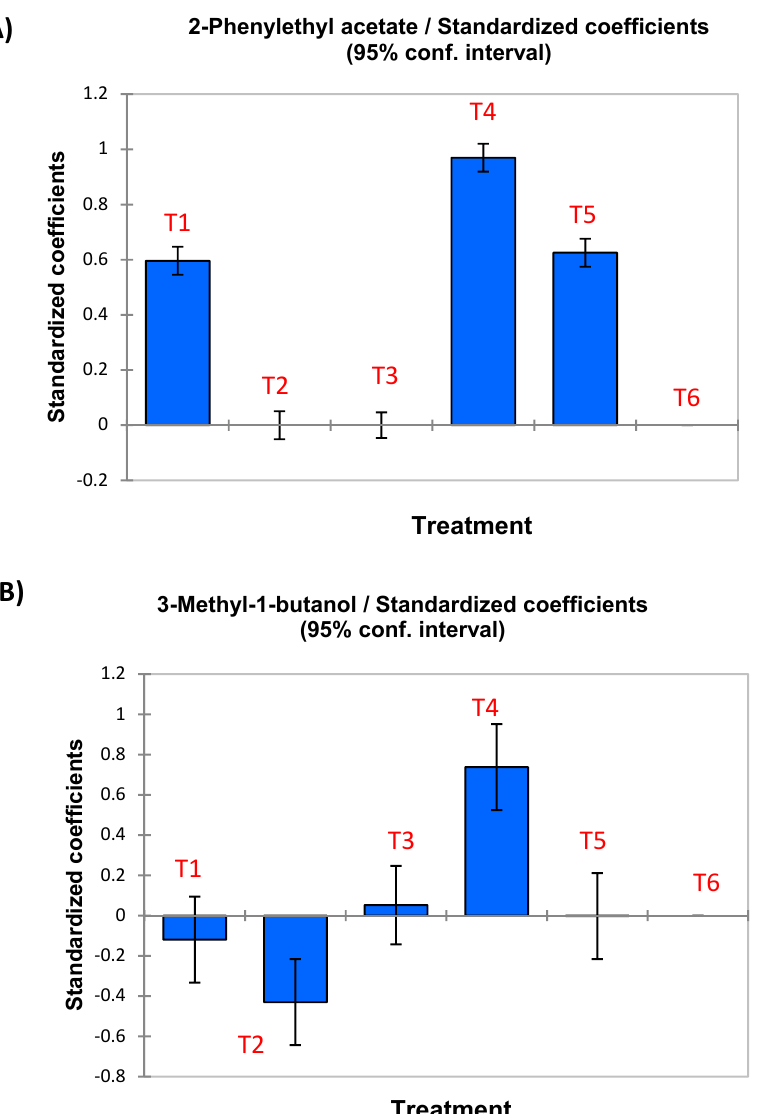
Figure 1. Standardised coefficients obtained after the ANOVA analysis (a n = O, equivalent to stablish T6 treatment, spontaneous fermentation, as standard) for two selected VOCs: ( A ) 2-phenylethyl acetate, and ( B ) 3-methyl-1-butanol.